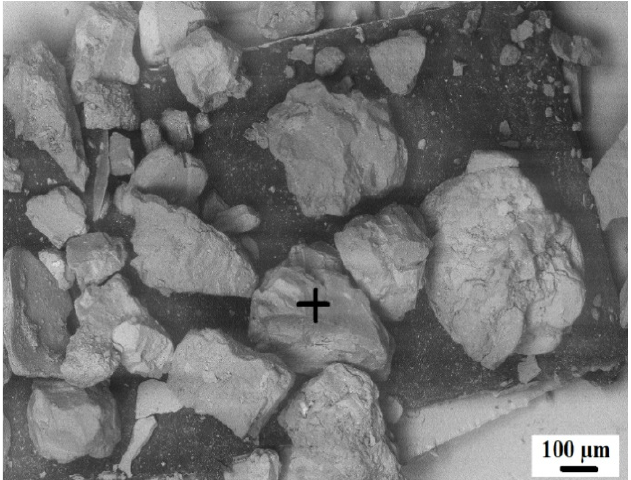
Figure 4. Microstructure of quarry dust.